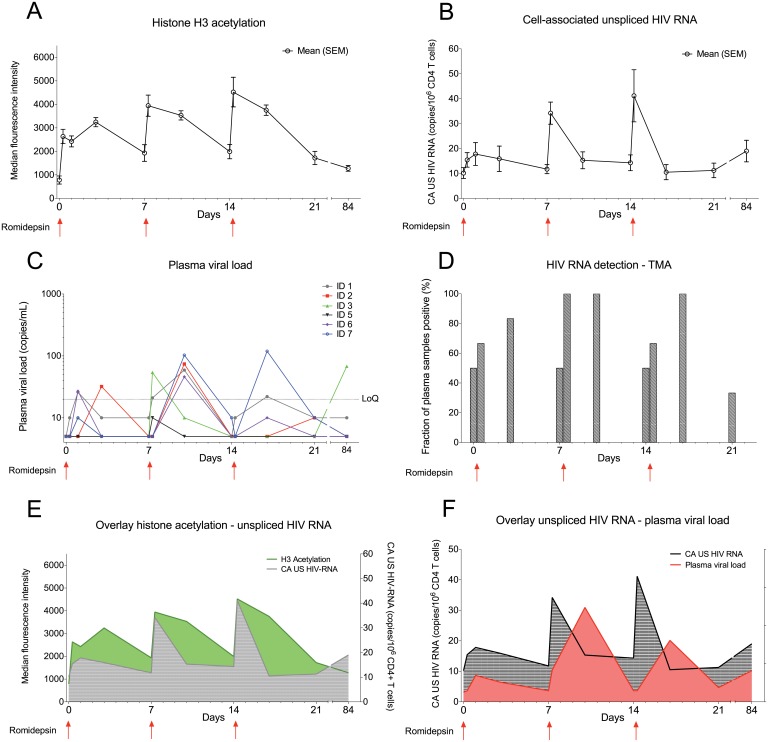
Romidepsin induced HIV-1 transcription and presence of extracellular viral RNA.Panel (A) shows mean (SEM) levels of H3 acetylation measured by flow cytometry in lymphocytes. (B) shows mean (SEM) change from baseline in the level of CA US HIV-1 RNA. The first sample time point after each of the 3 romidepsin doses is approximately ½ hour after end of the 4 hour infusion. (C) shows individual levels of plasma HIV-1 RNA, determined using the Roche Cobas Taqman assay, while panel (D) shows mean plasma HIV-1 RNA data for all 6 participants determined using a Transcription-Mediated Amplication assay. (E) is an overlay of H3 acetylation and CA US HIV-1 RNA data presented in Panels A and B. (F) is an overlay of CA US HIV-1-RNA (B) and plasma HIV-1 RNA (E). SEM, standard error of mean; CA US HIV-1-RNA: cell-associated unspliced HIV-1 RNA; LoQ, limit of quantitation; TMA, Transcription-Mediated Amplication. Statistical comparisons were performed using Wilcoxon matched-pairs signed-ranks test, Asterisk indicate p<0.05.